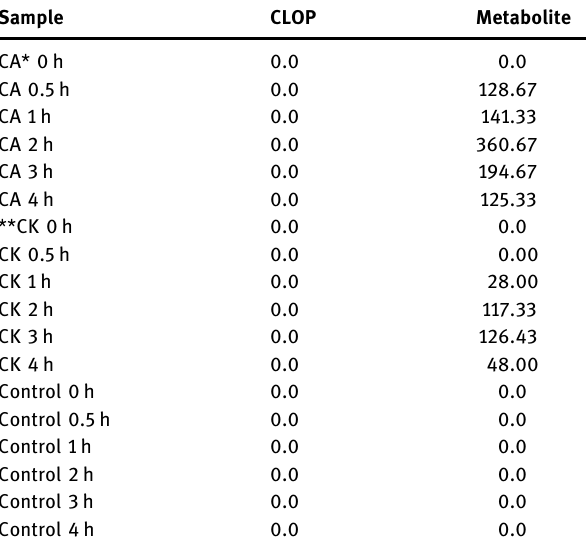
Table 4: Concentration of CLOP and its metabolite at di ff erent time intervals Sample